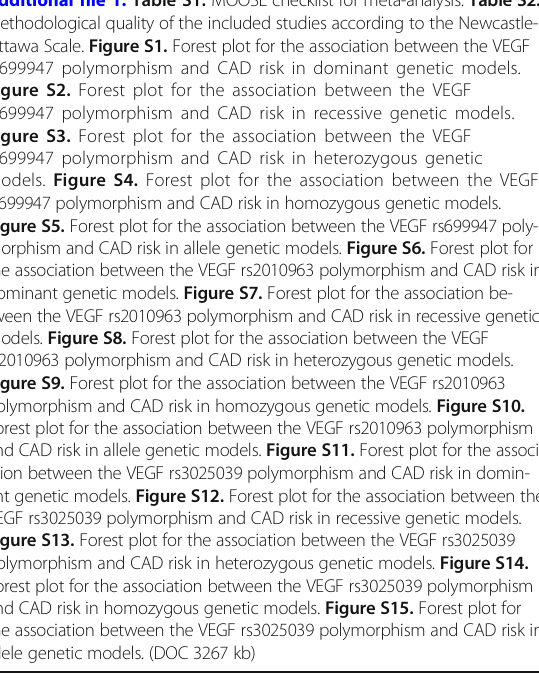
Figure S2. Forest plot for the association between the VEGF rs699947 polymorphism and CAD risk in recessive genetic models. Figure S3. Forest plot for the association between the VEGF rs699947 polymorphism and CAD risk in heterozygous genetic models. Figure S4. Forest plot for the association between the VEGF rs699947 polymorphism and CAD risk in homozygous genetic models. Figure S5. Forest plot for the association between the VEGF rs699947 poly- morphism and CAD risk in allele genetic models. Figure S6. Forest plot for the association between the VEGF rs2010963 polymorphism and CAD risk in dominant genetic models. Figure S7. Forest plot for the association be- tween the VEGF rs2010963 polymorphism and CAD risk in recessive genetic models. Figure S8. Forest plot for the association between the VEGF rs2010963 polymorphism and CAD risk in heterozygous genetic models. Figure S9. Forest plot for the association between the VEGF rs2010963 polymorphism and CAD risk in homozygous genetic models. Figure S10. Forest plot for the association between the VEGF rs2010963 polymorphism and CAD risk in allele genetic models. Figure S11. Forest plot for the associ- ation between the VEGF rs3025039 polymorphism and CAD risk in domin- ant genetic models. Figure S12. Forest plot for the association between the VEGF rs3025039 polymorphism and CAD risk in recessive genetic models. Figure S13. Forest plot for the association between the VEGF rs3025039 polymorphism and CAD risk in heterozygous genetic models. Figure S14. Forest plot for the association between the VEGF rs3025039 polymorphism and CAD risk in homozygous genetic models. Figure S15. Forest plot for the association between the VEGF rs3025039 polymorphism and CAD risk in allele genetic models. (DOC 3267 kb) Abbreviations CAD: Coronary artery disease; CIs: Confidence intervals; HWE: Hardy – Weinberg equilibrium; MI: Myocardial infarction; MOOSE: Meta – analysis